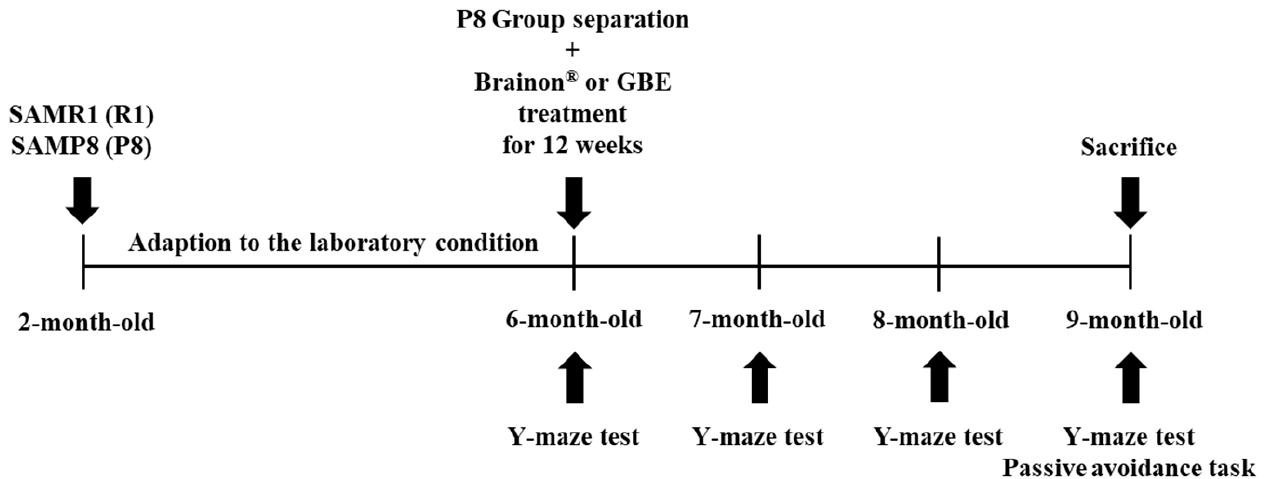
Figure 2. Schematic representation of the experimental design.